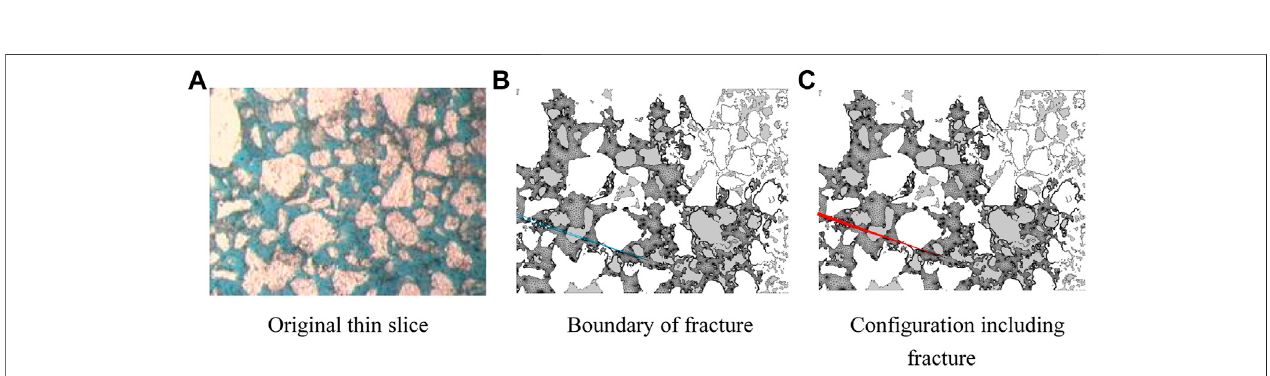
Frontiers in Earth Science |